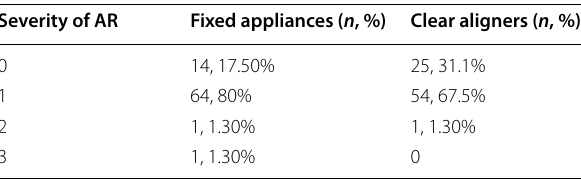
Table 6 Classification of overall severity of apical root resorption in the two groups Severity of